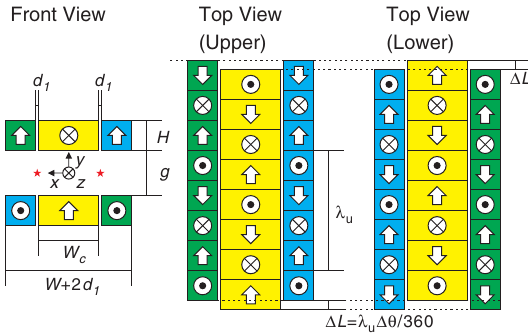
FIG. 5. Geometry to calculate the performance of the SPIN